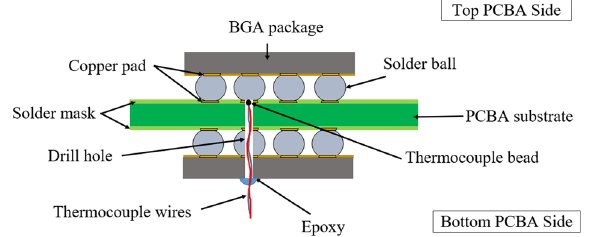
Figure 9. Schematic of TC wire placement on BGA component solder